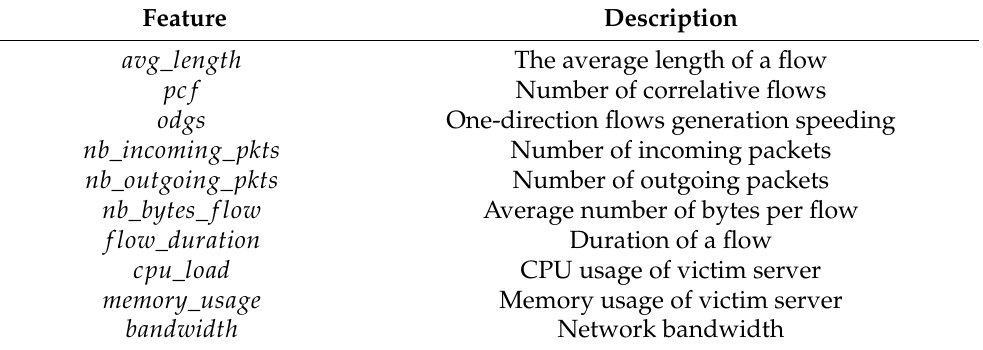
Table 2. Key Features for ANN